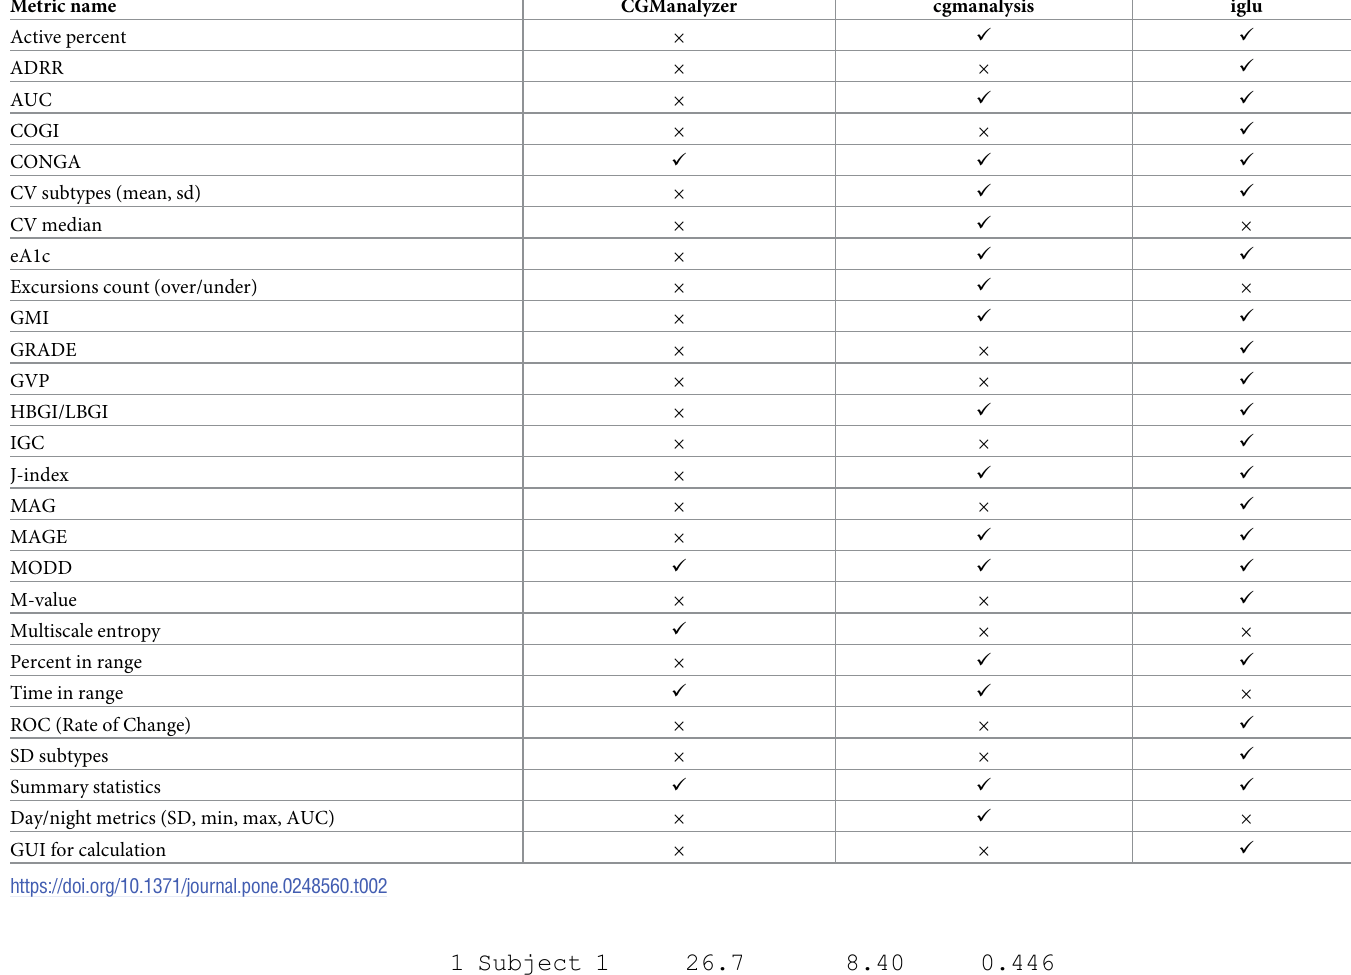
Table 2. Comparison of iglu functionality with existing R packages for CGM data. Metric